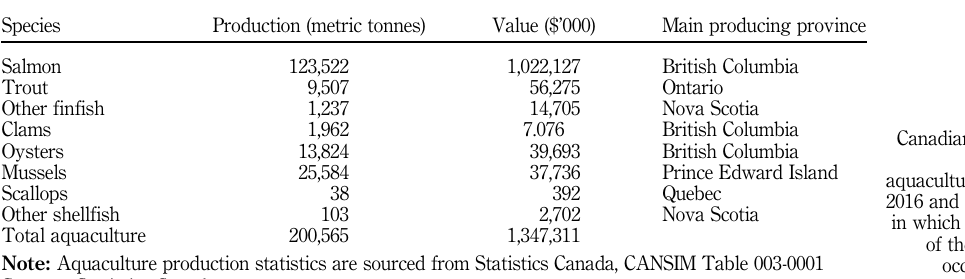
Table IV. Canadian